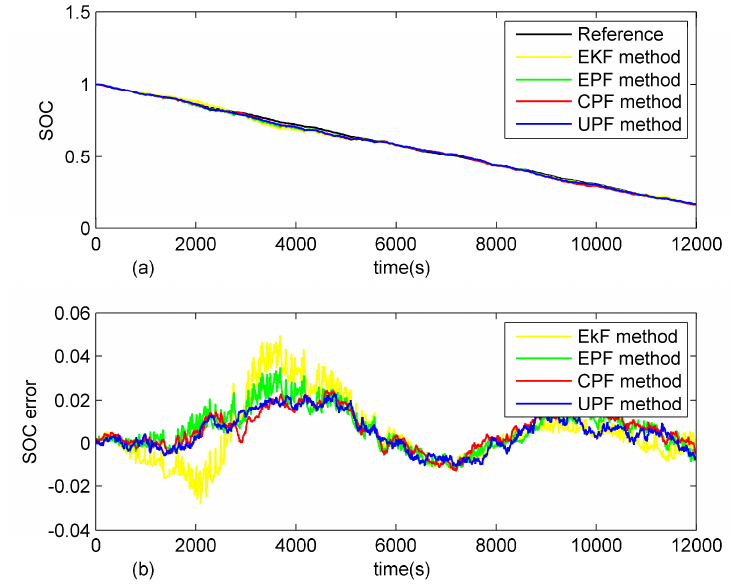
Figure 5. Comparison of SOC estimation accuracy under the City test: ( a ) SOC estimation; and ( b ) SOC estimation error.